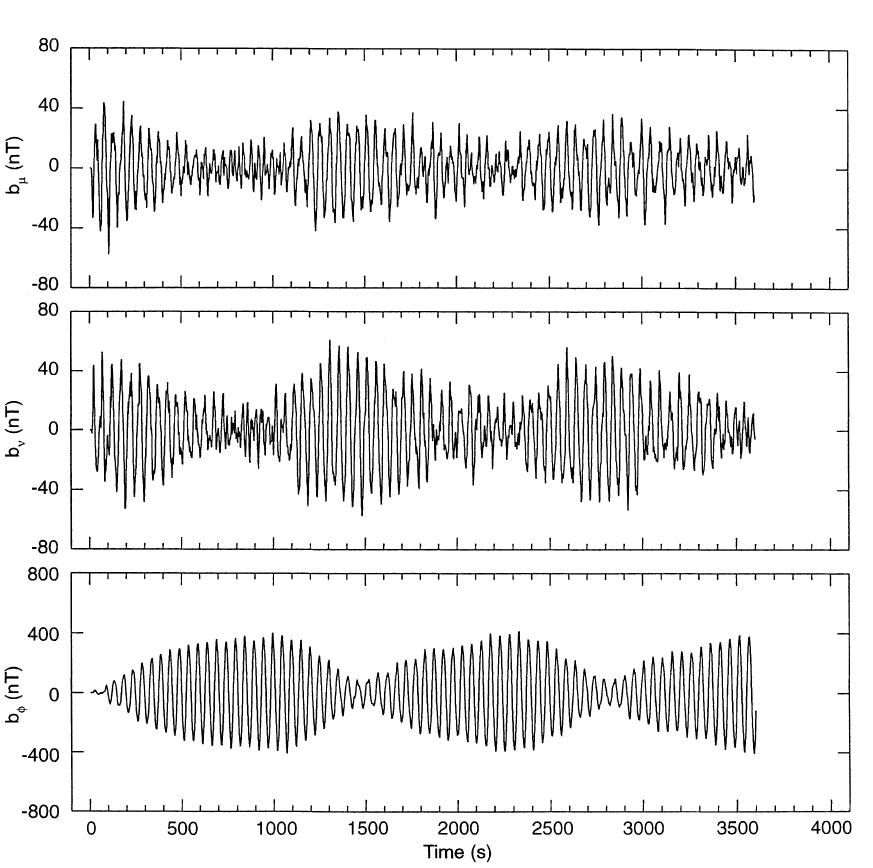
Fig. 7. Time series of the magnetic field components at a grid point near the equatorial plane on the magnetic shell closest to the field line resonance (low